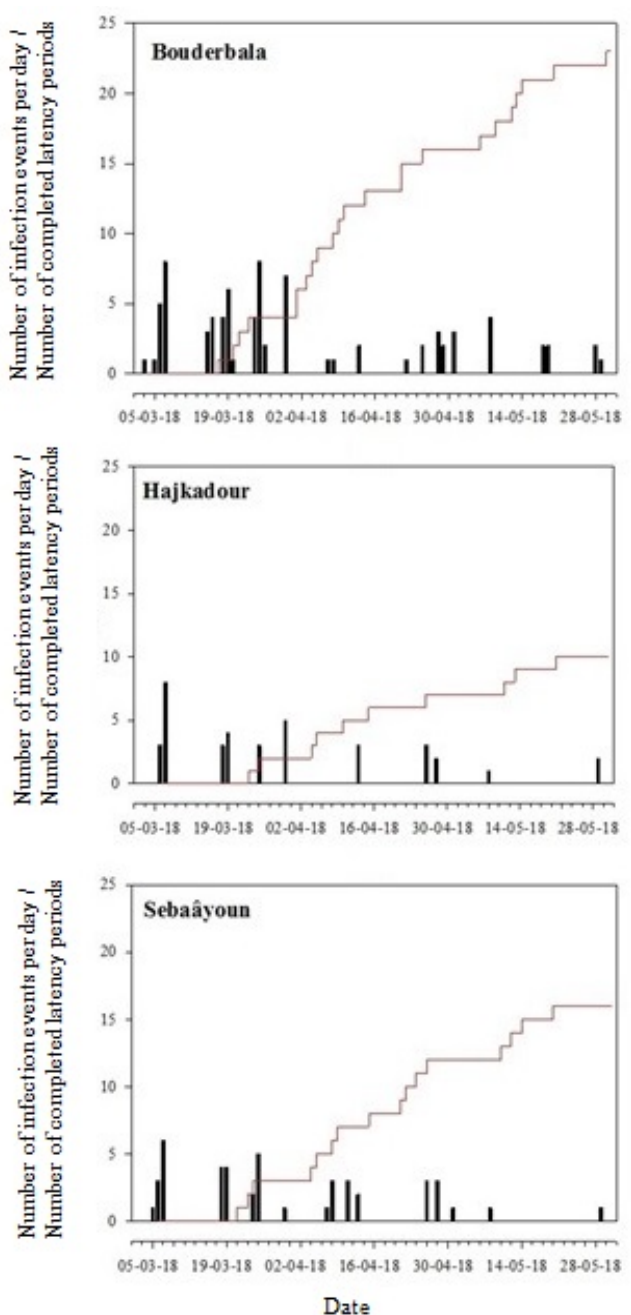
Figure 6. Model evaluation #1: simulated infection events per day (bars) and number of completed latency periods (lines) during March–May 2018. The model evaluation #1 was performed using data of 2017/2018 cropping season for three sites (Bouderbala, Hajkadour and Sebaâyoun).